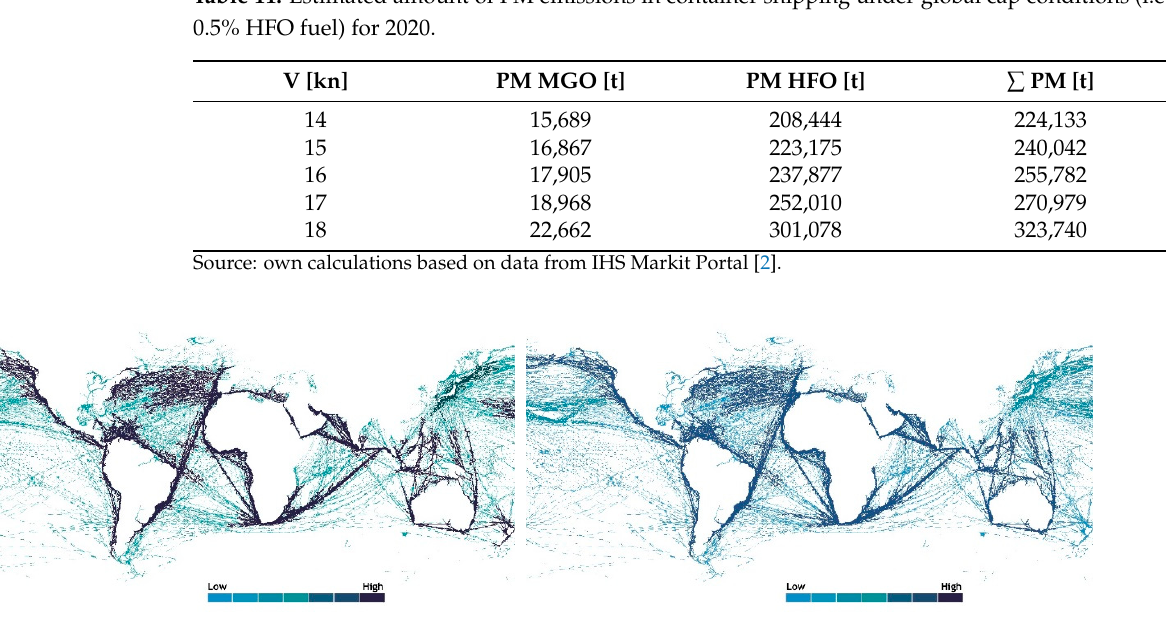
Table 11. Estimated amount of PM emissions in container shipping under global cap conditions (i.e.,